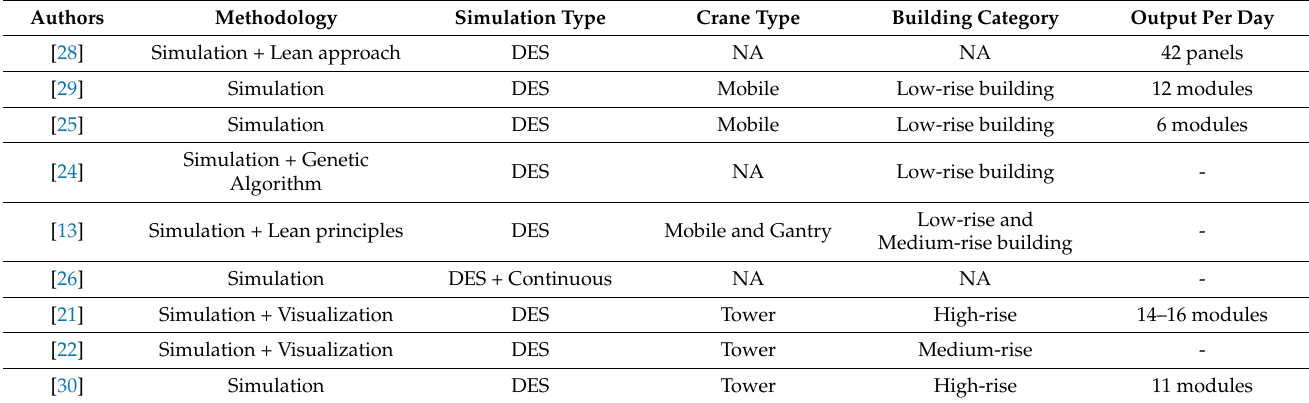
Table 1. Summary of previous studies relating to MiC prefabrication and on-site